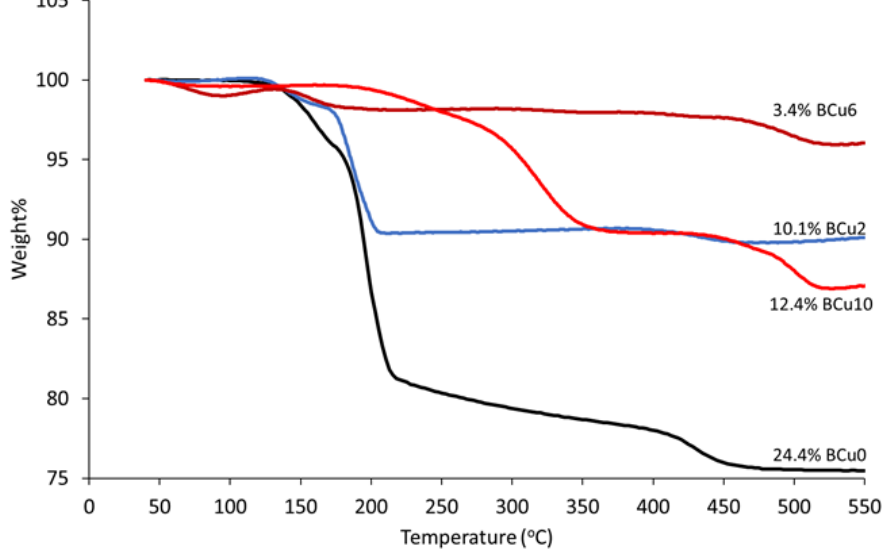
Figure 6. TG curves of Ca-Cu phosphates .